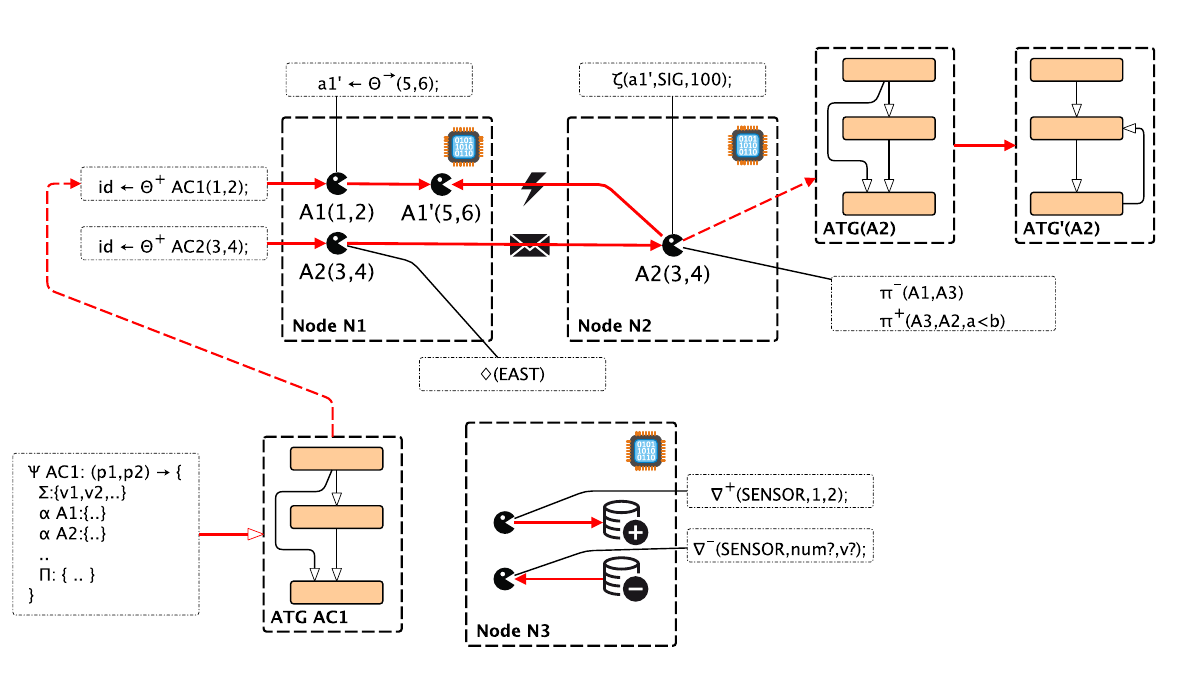
Figure 4. Effects of AAPL statements on the behavior of a multi-agent